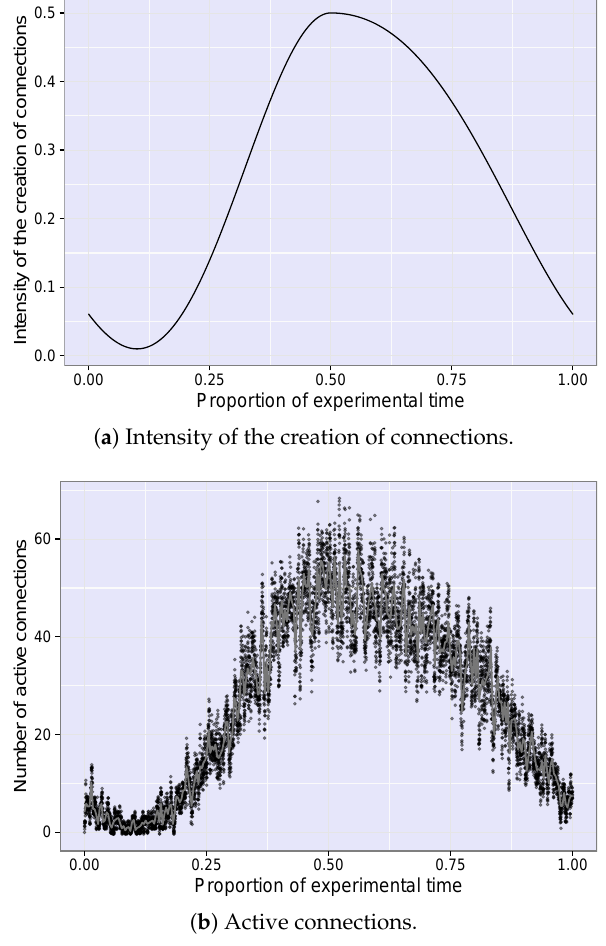
Figure 6. Analysis of generated load. ( a ) represents the intensity models for new connections; ( b ) represents the resulting connections: average activity in 5 min is displayed with a gray